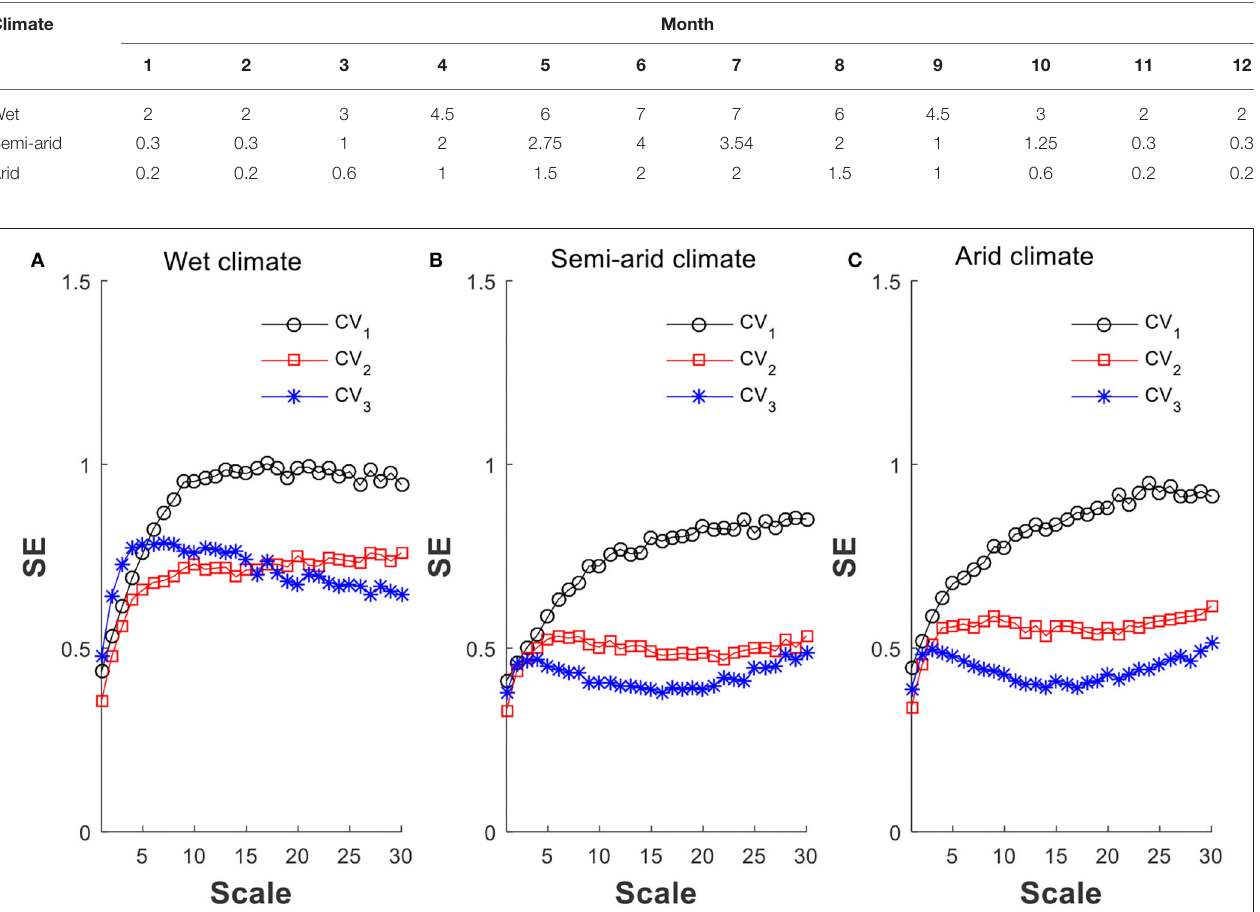
TABLE 1 | Monthly daily µ x (mm/day) for different climates.